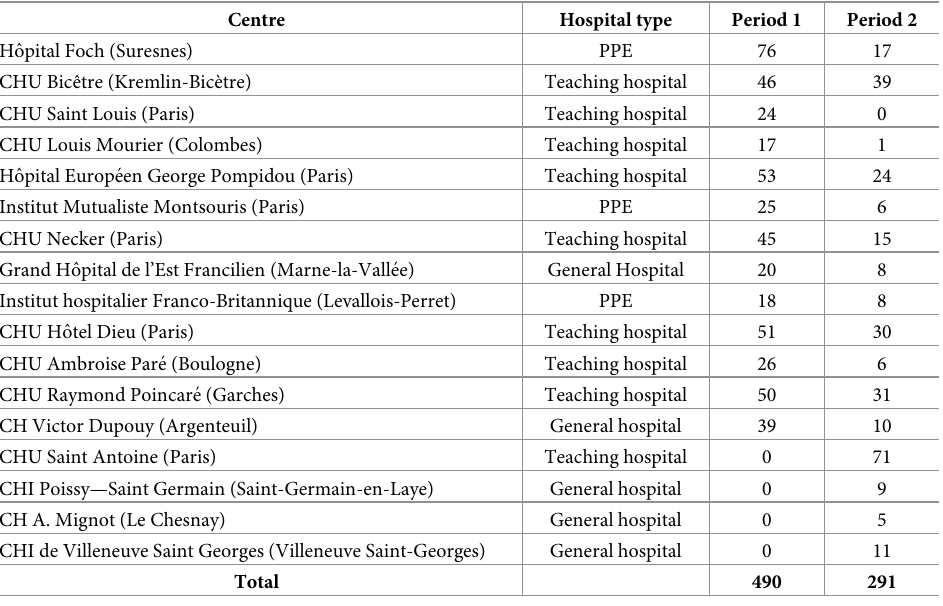
Table 1. Number of patients included by each